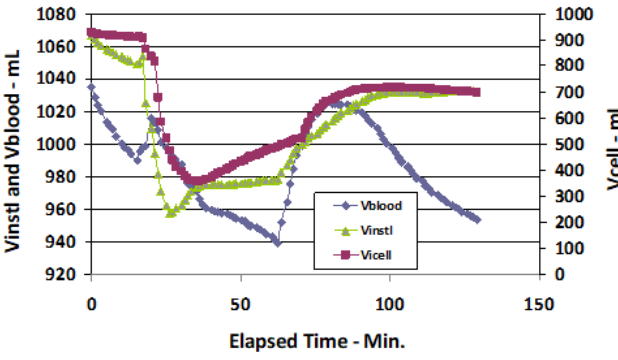
Figure 5. Vblood, Vinst and Vcell compartment volumes (mL) of the calf during the total DTM treatment and recovery periods vs. Elapsed Time (min).